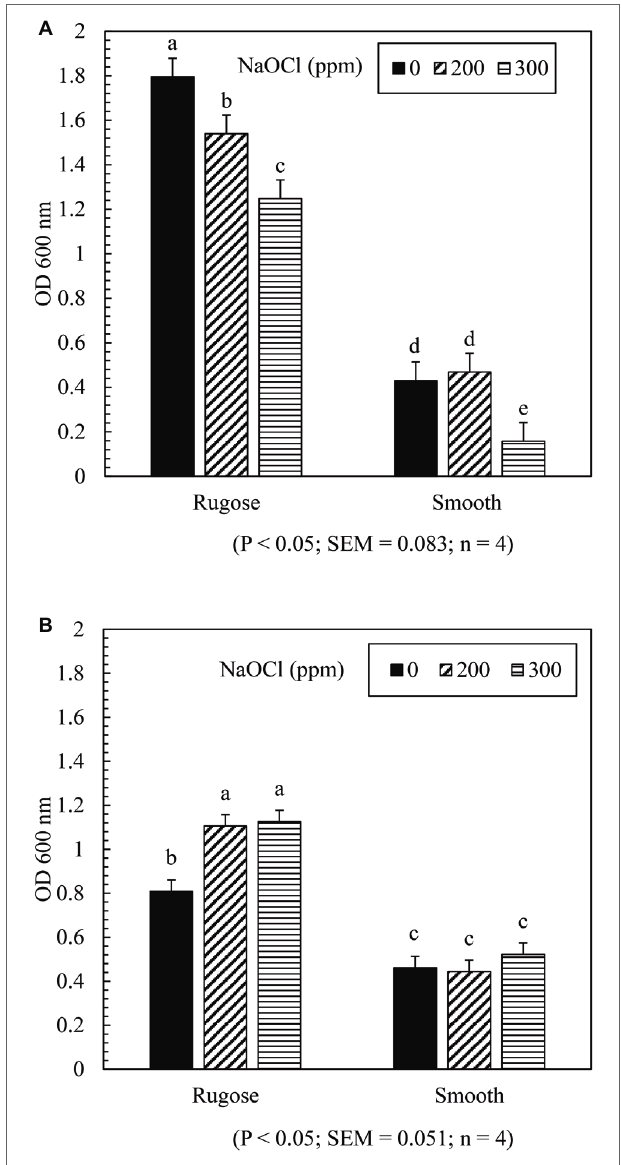
FIGURE 3 | Effect of subinhibitory concentrations (SICs) of NaOCl on biofilm formation of rugose and smooth morphotypes of S. Typhimurium ATCC 14028 (A) and S. Heidelberg ATCC 8326 (B) . Bars represent average OD 600 value of biofilm formation of S. Typhimurium and S. Heidelberg after staining with crystal violet. The black, diagonal and horizontal bar represents biofilm formation of negative control (without NaOCl exposure), and in the presence of SICs of 200 or 300 ppm NaOCl in TSB of rugose and smooth morphotype,